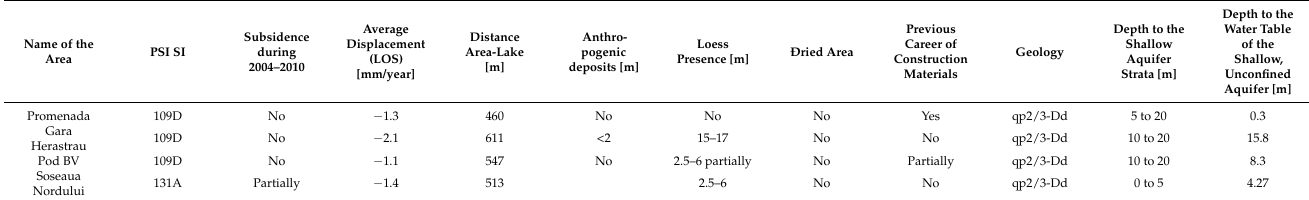
Table 4. Processed information for Promenada, Pod BV, Gara Herastrau, and Soseaua Nordului areas. Used data sources